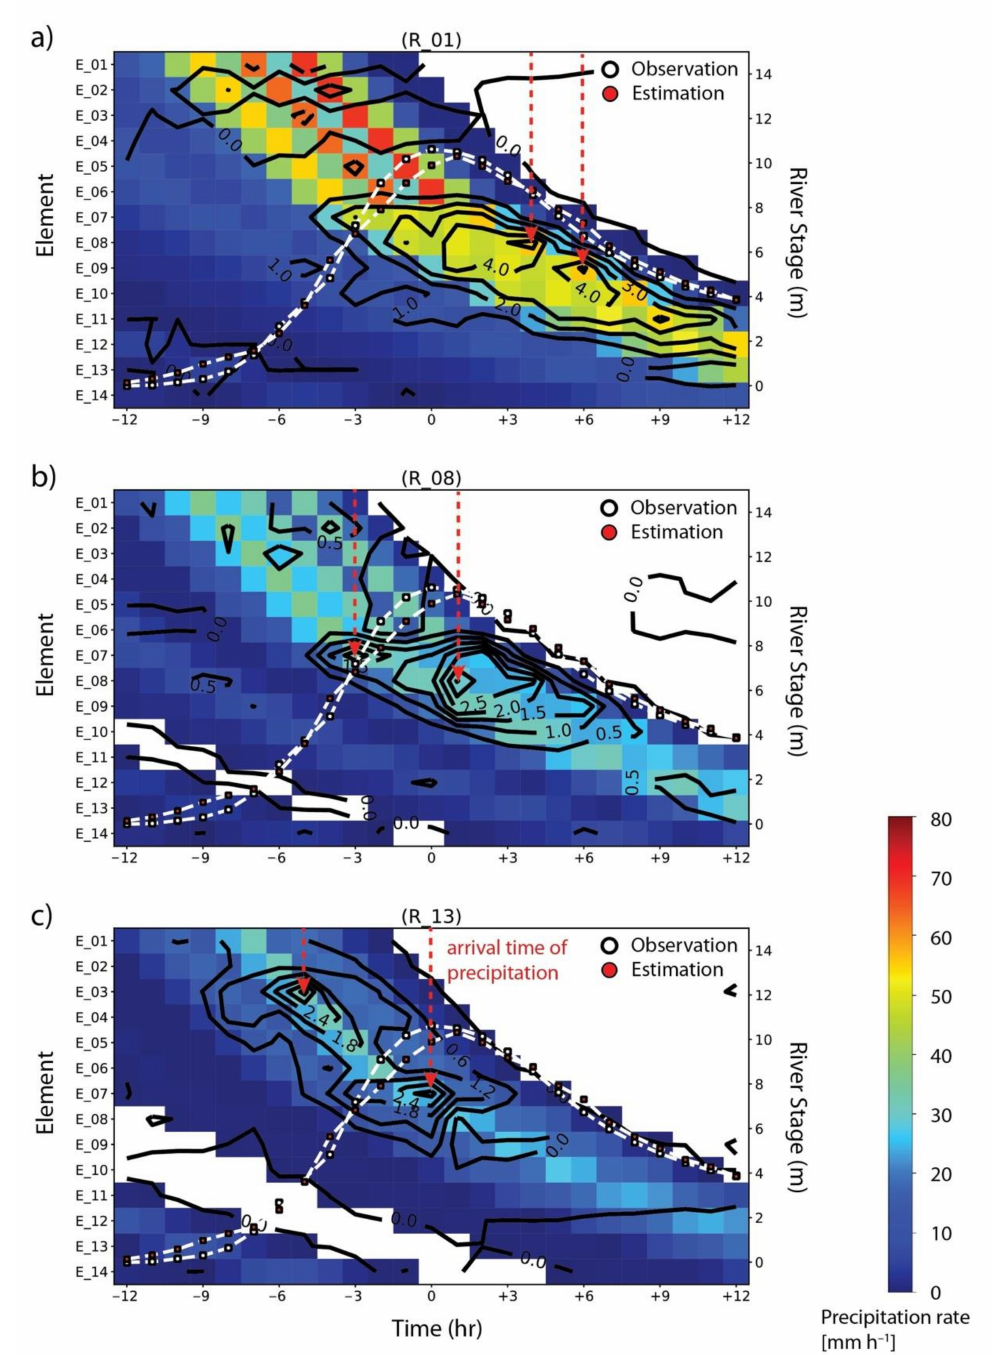
Figure 13. Relevance map of the stage estimation MLP model for case 2 and three rain gauges along the main stream (Figure 1). The abscissa is the time from the stage peak. The left ordinate is the precipitation element (Table 3), with its relevance marked as black contours. The right ordinate is the stage, with the white dashed curves showing observed (white-filled circles) and estimated (red-filled circles) stages. Color fill is input precipitation. ( a ) Gauge R_01. ( b ) Gauge R_08. ( c ) Gauge R_13. The red arrows indicate the estimation of the arrival time of